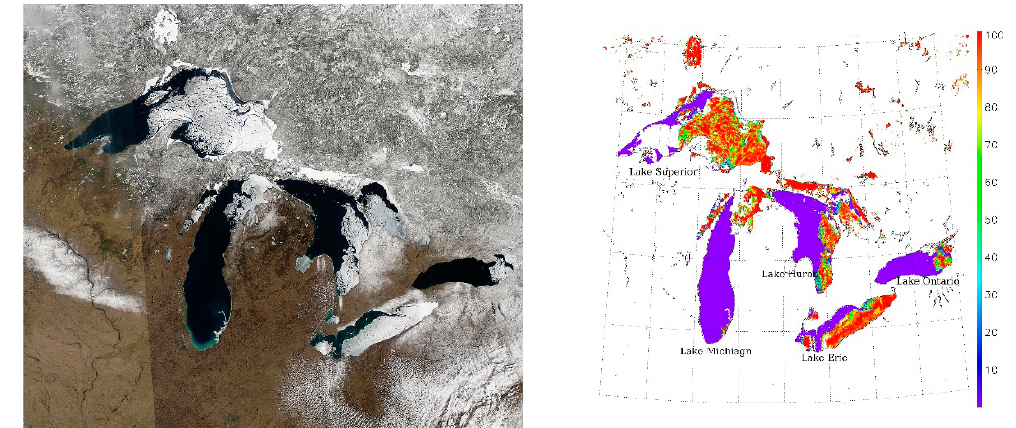
Figure 11. Aqua MODIS true-color image at 6:20 p.m. UTC on 28 March 2015 ( left ); and the corresponding ice concentration ( right ).